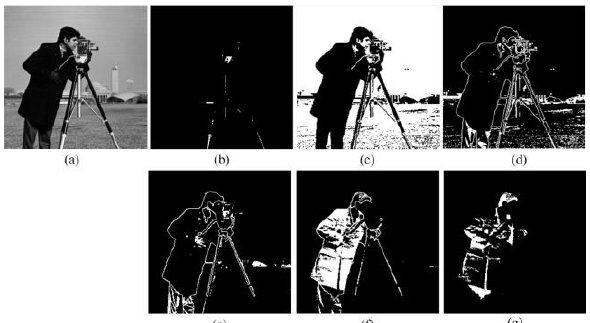
Figure 2. An example of PCNN segmentation of the cameraman image. (a) The original cameraman image, (b) - (g) The segmentation results in different iterations of PCNN